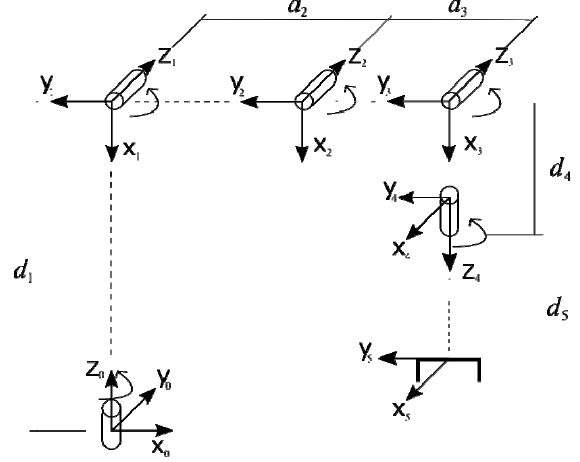
Figure 4. Coordinate frames of the robot.